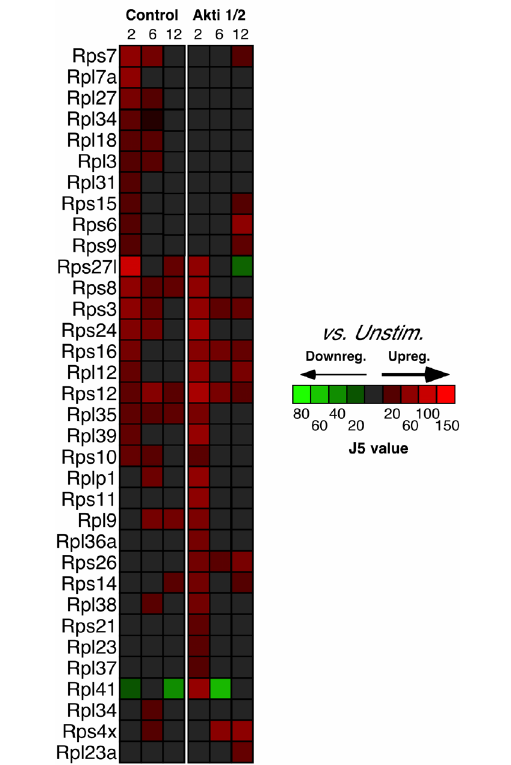
Figure 3. Akt-dependent ribosomal subunit genes differentially expressed between control (0 h) and 2 h, 6 h and 12 h CD3/CD28 stimulation groups. Relative levels of expression are represented by the J5